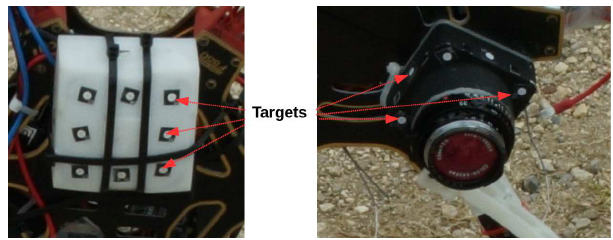
Figure 3: Targets fixed on the sensors